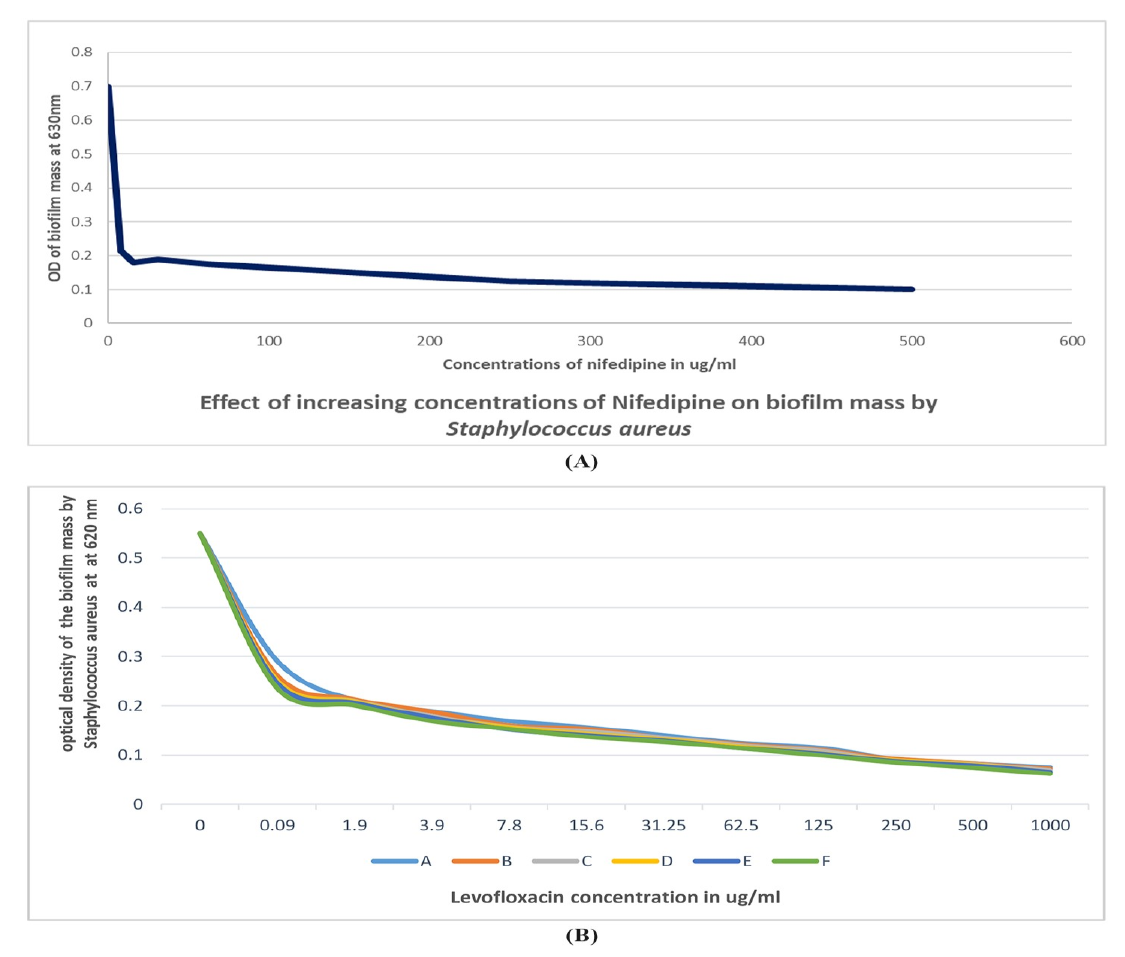
Figure 3. A Effect of nifedipine increasing concentrations on biofilm formed mass by S. aureus B Effect of combination of nifedipine and levofloxacin on biofilm forming capacity of S. aureus.